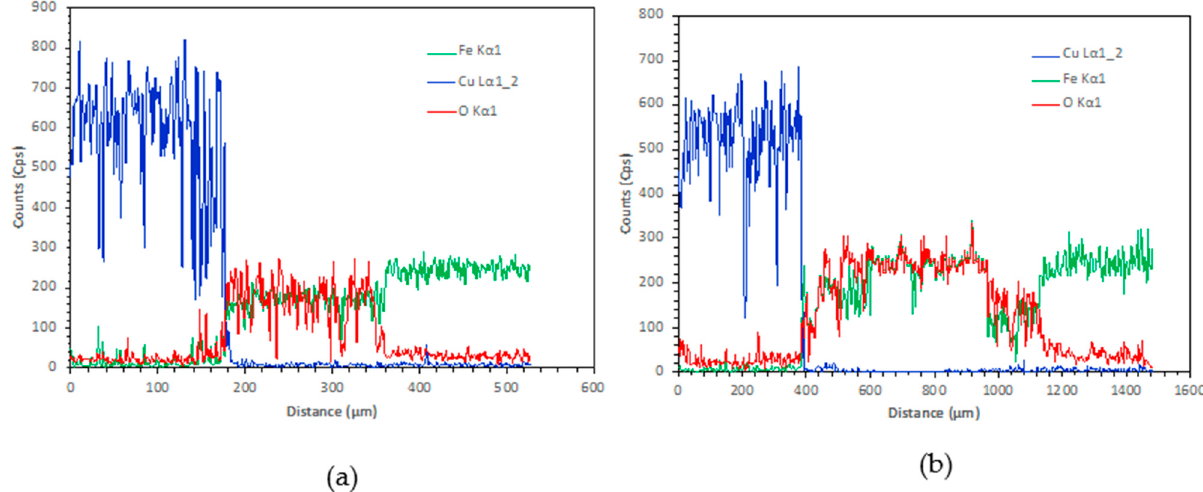
Figure 7. Energy-dispersive X-ray spectroscopy (EDS)of QMMC prepared at ( a ) 800 °C and ( b ) 1200 °C.